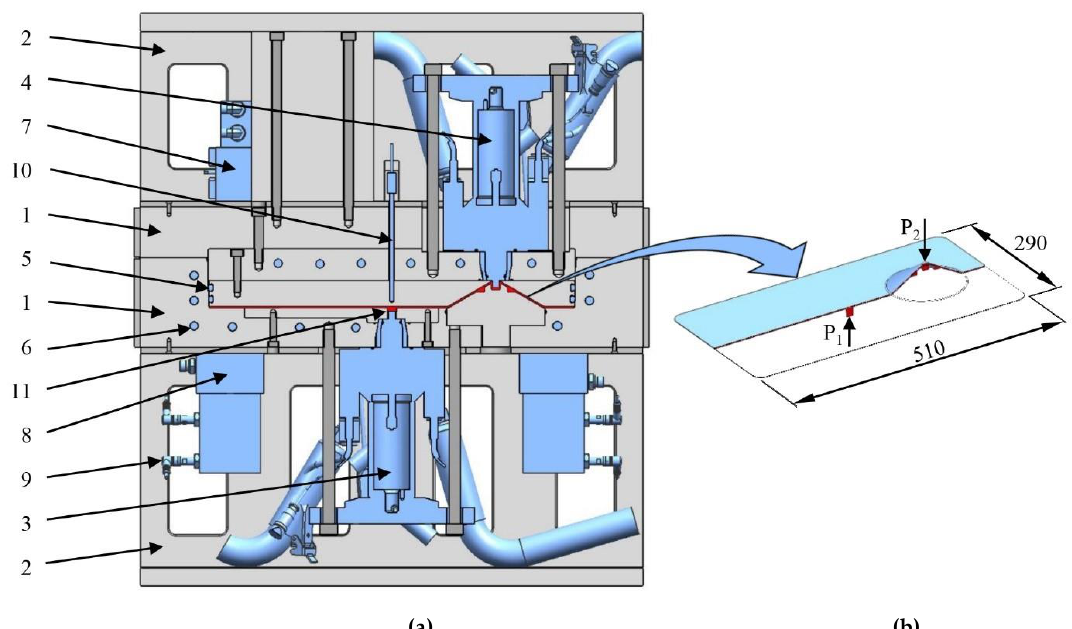
Figure 4. ( a ) The research T-RTM mold (1—form plates; 2—supporting structure; 3—first mixing head; 4—second mixing head; 5—sealing; 6—oil temperature controllers; 7—vacuum system; 8—hydraulic ejector system; 9—position sensor of the ejector system; 10—temperature sensor; 11—pressure sensors). ( b ) The cross-section of the formed part (P 1 —first inlet point; P 2 —second inlet point).